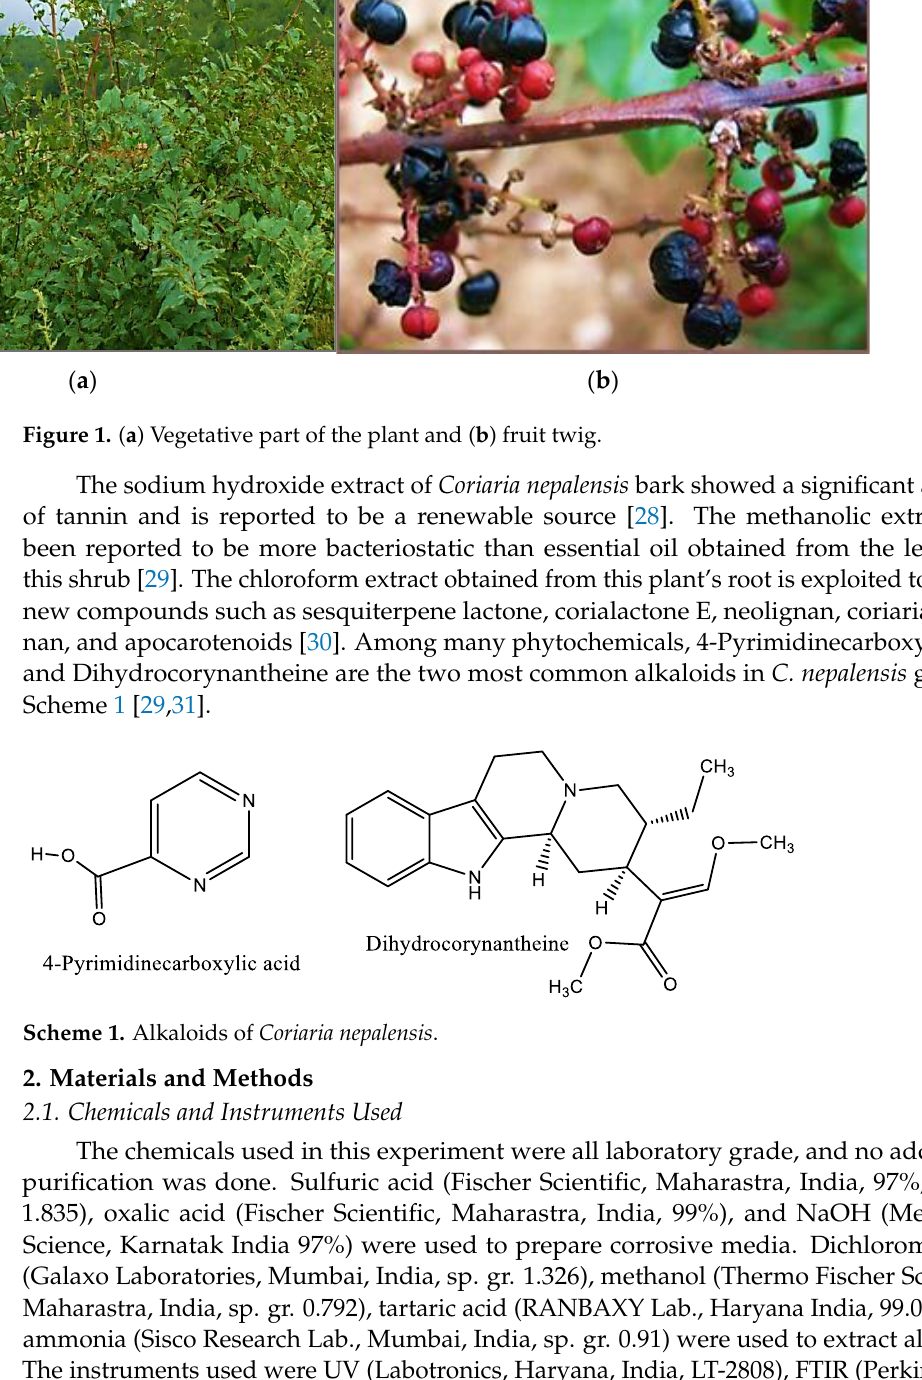
twig are shown in Figure 1.